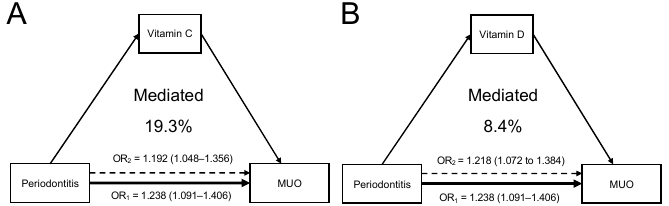
Figure 4. Serum antioxidant vitamins play a mediating role in the periodontitis–MUO link. ( A ) Serum vit-amin C mediated 19.3% of the association between periodontitis and MUO. ( B ) Serum vitamin D mediated 8.4% of the association.